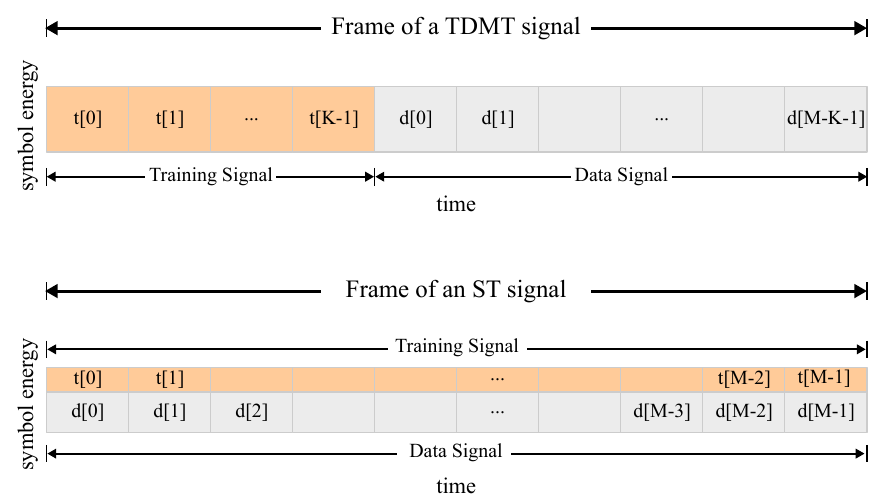
Figure 1. Comparison of frame structures for the time domain multiplexed training (TDMT) scheme ( top ) and the superimposed training (ST) scheme ( bottom